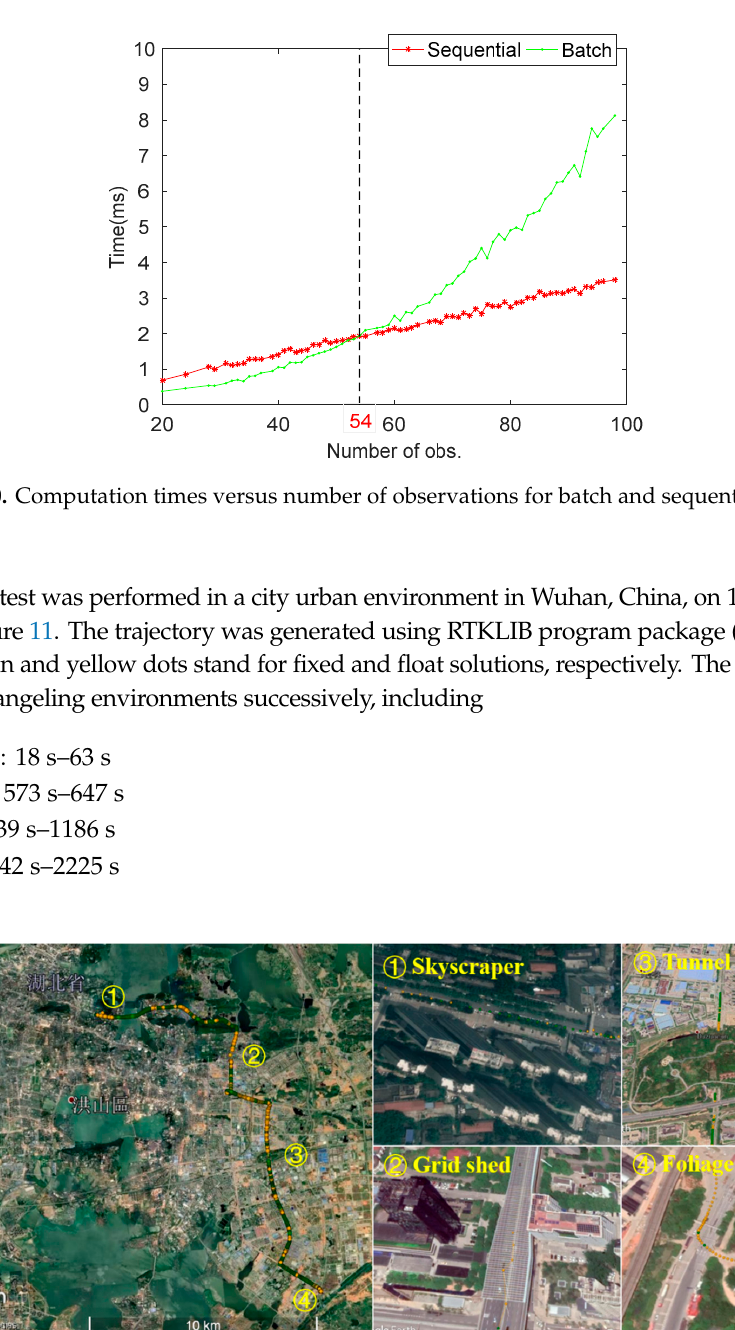
14 of 19 Figure 9. Computation times of measurement update for LC, TC-PD, and TC-PDC. Table 6. Mean value of computation times for LC, TC-PD, and TC-PDC. Batch ( ms ) Sequential ( ms )